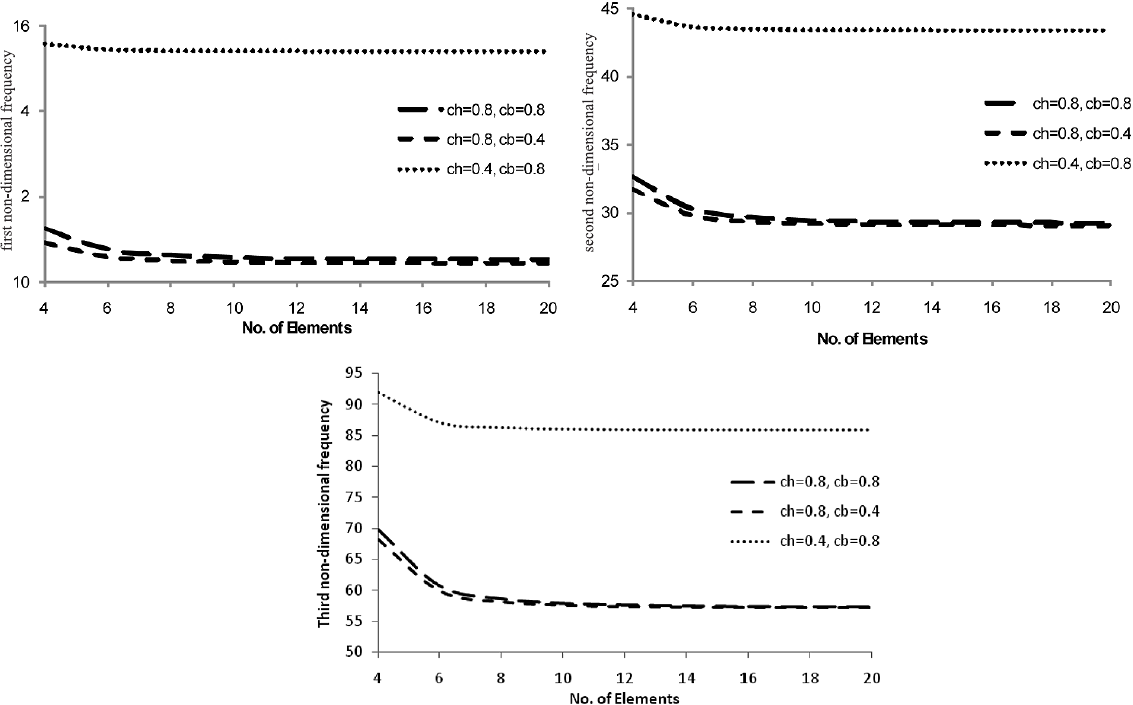
Fig. 4. Cnvergence of the element in free transverse vibration of a C-C axially FG tapered